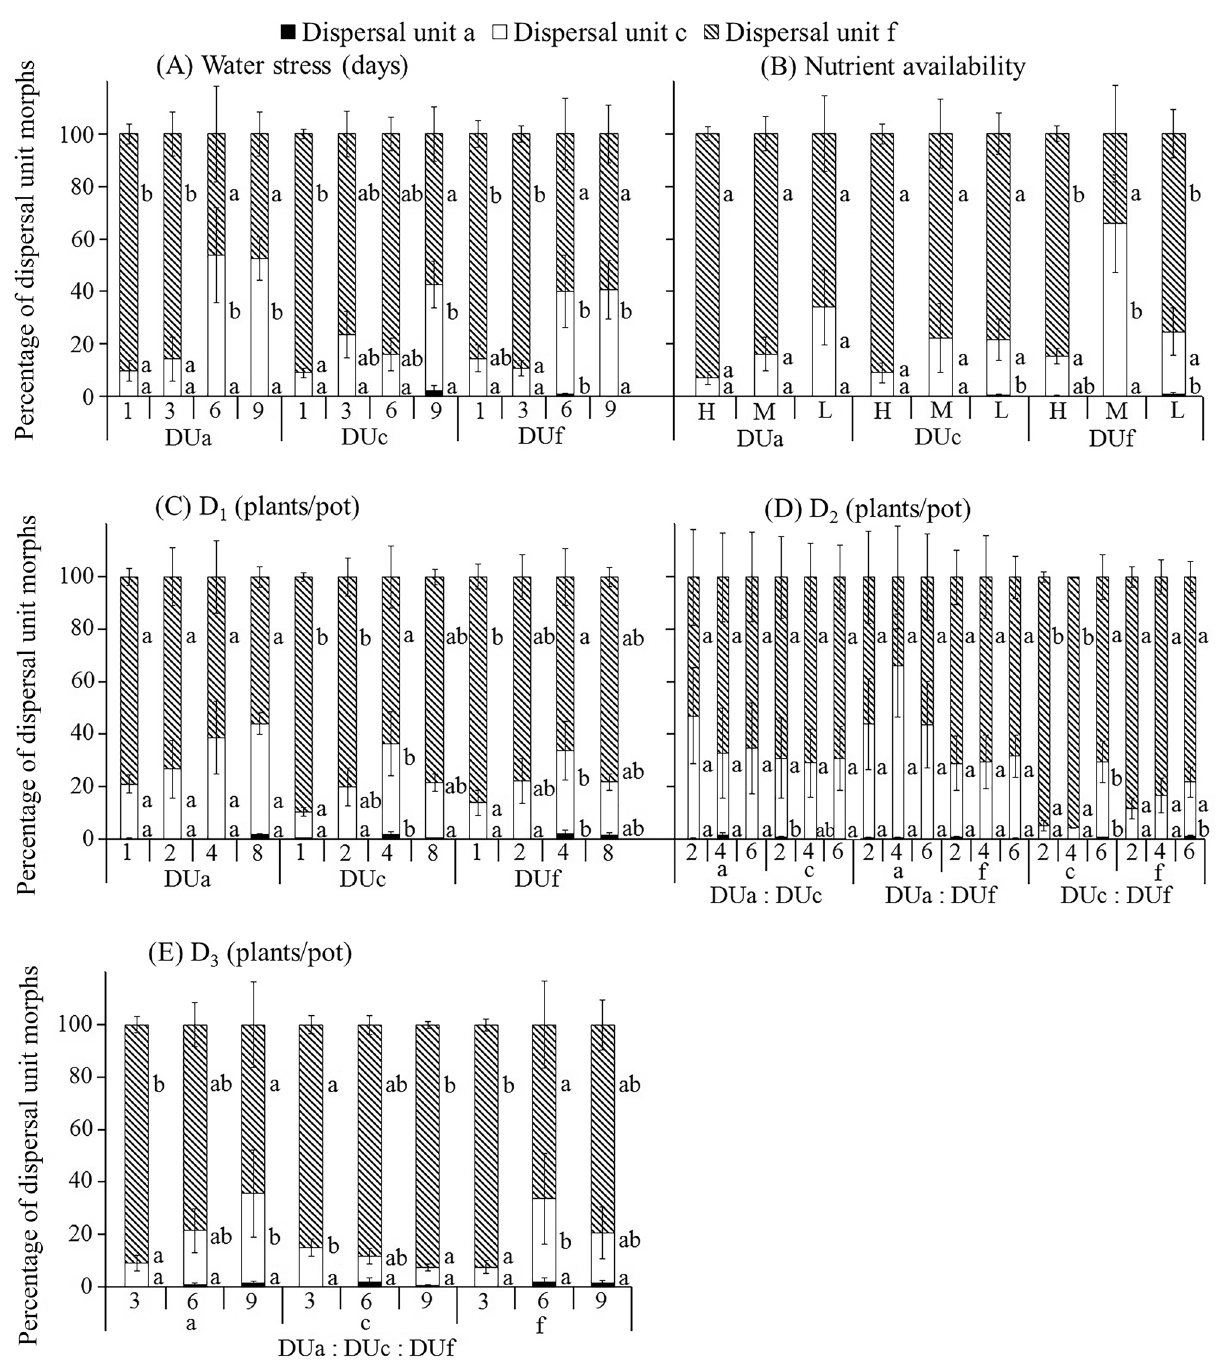
Figure 6. Effects of water stress ( A ), nutrient availability ( B ) and pure ( C ) and mixed ( D , E ) density on percentage of dispersal unit morphs a, c and f of Ceratocarpus arenarius plants derived from each dispersal unit morph (mean ± 1 s.e.). Only percentages of each dispersal unit morph ≥ 0.51% and standard errors ≥ 0.89% are shown. Different lowercase letters indicate significant difference in multiple range comparison among levels for all treatments of plants from the same dispersal unit morph ( P < 0.05). DUa, dispersal unit morph a; DUc, dispersal unit morph c; DUf, dispersal unit morph f; H, high; M, moderate; L,